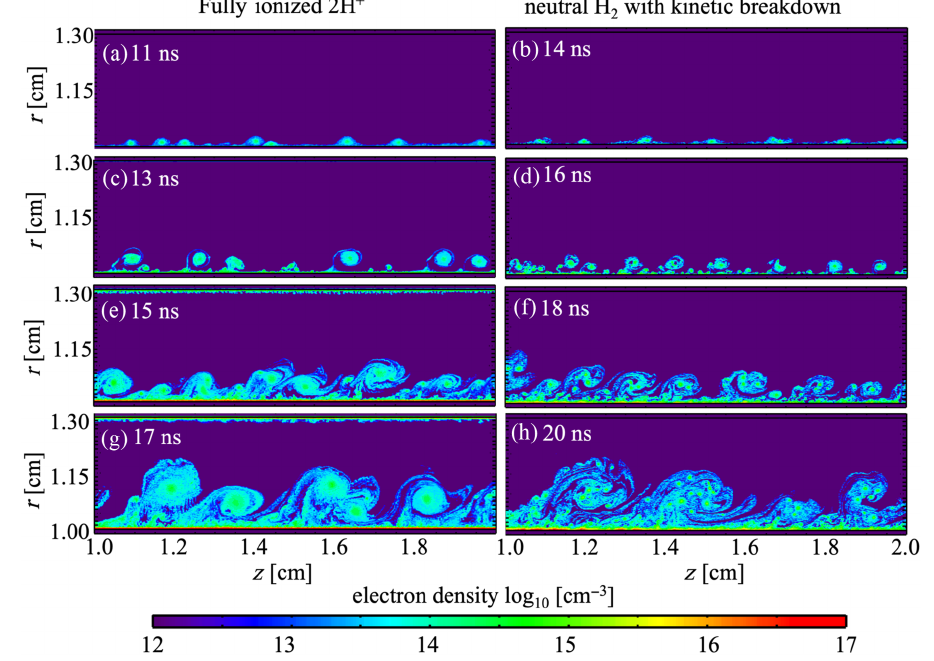
FIG. 9. The electron density contours that result when full ionization is assumed (left) and when the ionization of desorbed contaminants is modeled (right). The fully ionized and kinetic-breakdown models are shown 4 times early in the 280-kA/ns pulse rise to demonstrate evolution. The density distributions from the breakdown model at (b) 14, (d) 16, (f) 18, and (h) 20 ns are comparable in radial extent to the fully ionized contours taken 3 ns earlier in the pulse (a) 11, (c) 13, (e) 15, and (g) 17 ns,